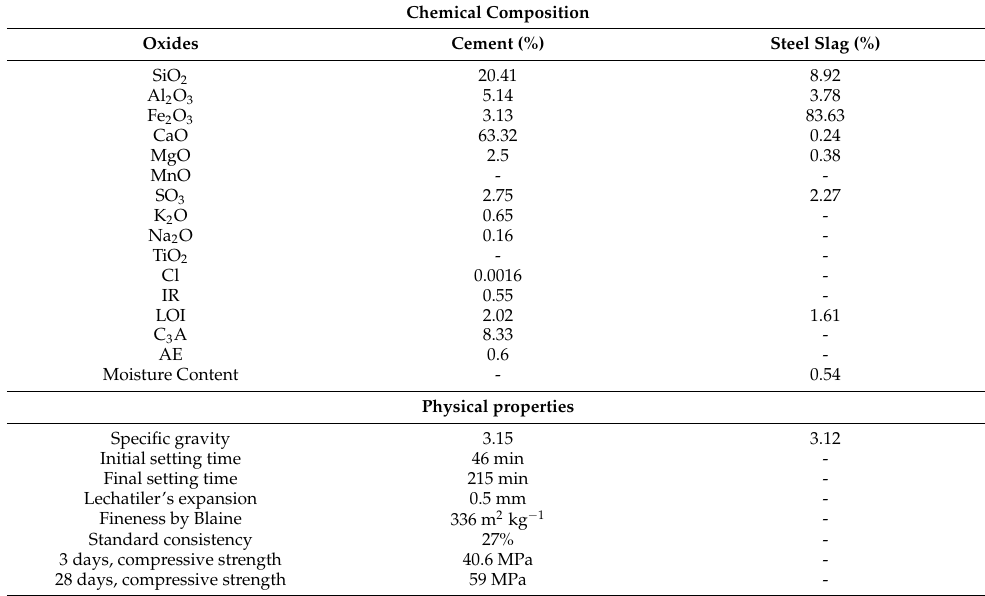
Table 1. Chemical and physical properties of cement and steel slag used.